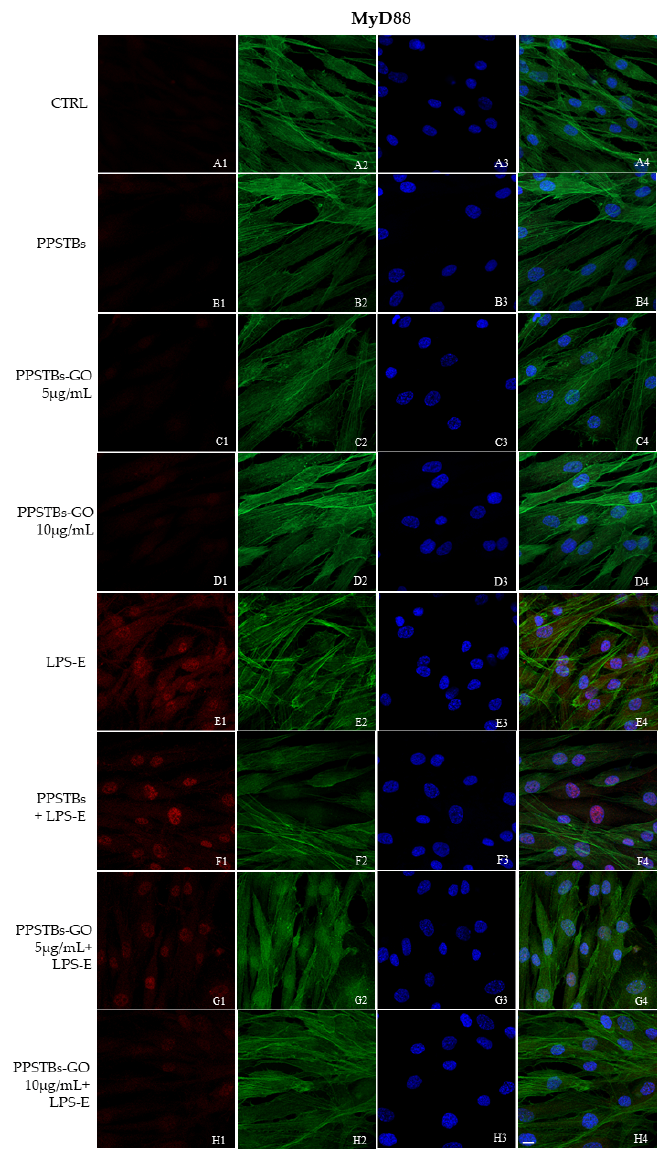
Figure 6. MyD88 signaling pathway in hGFs cell line. Expression of MyD88 analyzed by confocal microscopy ( A1 – H4 ), MyD88 expression untreated cells (CTRL), in hGFs cultured with PPSTBs, in hGFs cultured with PPSTBs enriched with GO at 5 μ g/mL, in hGFs cultured with PPSTBs enriched with GO at 10 μ g/mL, in hGFs stimulated with LPS ‐ E, in hGFs cultured with PPSTBs and stimulated with LPS ‐ E, in hGFs cultured with PPSTBs enriched with GO at 5 μ g/mL and stimulated with LPS ‐ E and in hGFs cultured with PPSTBs enriched with GO at 10 μ g/mL and stimulated with LPS ‐ E. Red fluorescence: Red fluorescence: MyD88 ( A1 – H1 ); Green fluorescence: cytoskeleton actin ( A2 – H2 ); Blue fluorescence: cell nuclei ( A3 – H3 ) and Merge ( A4 – H4 ). Scale bar: 20 μ m.